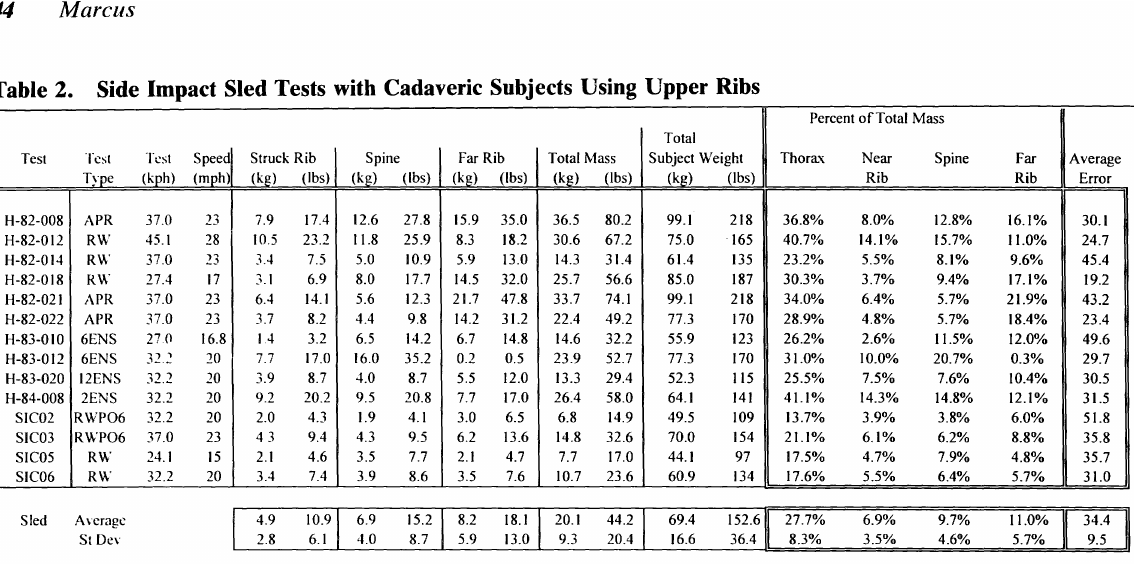
Sled A\wage SI Dc\"